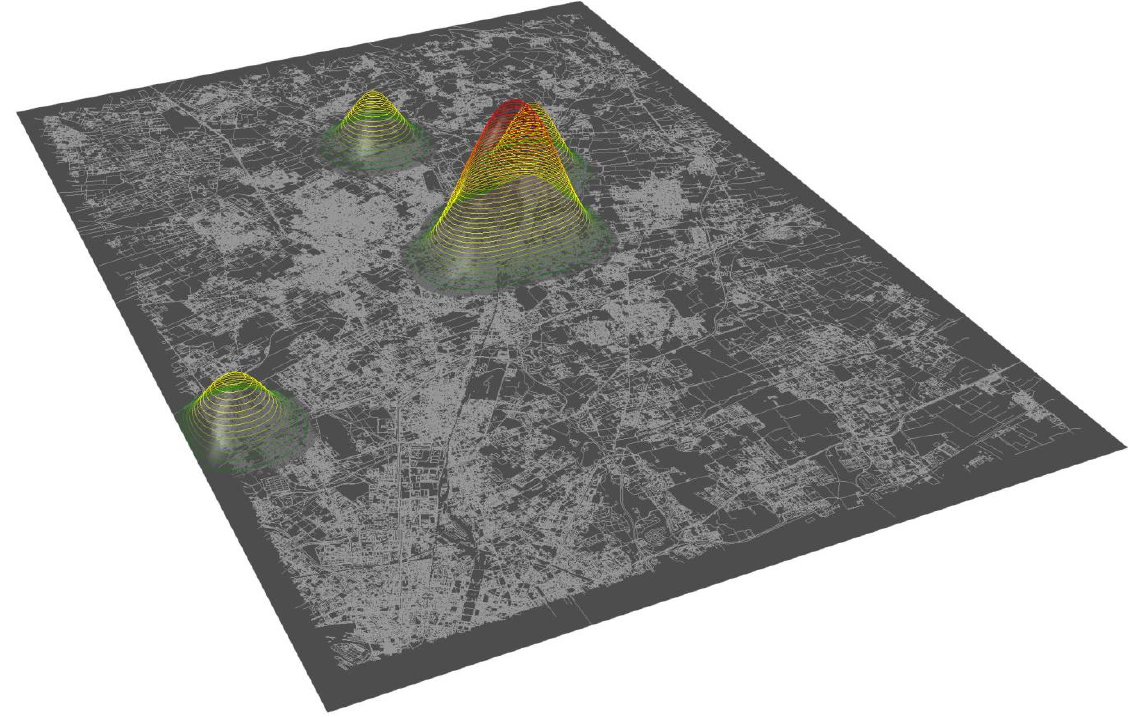
Figure 4. Tweets mapping dated 24rd